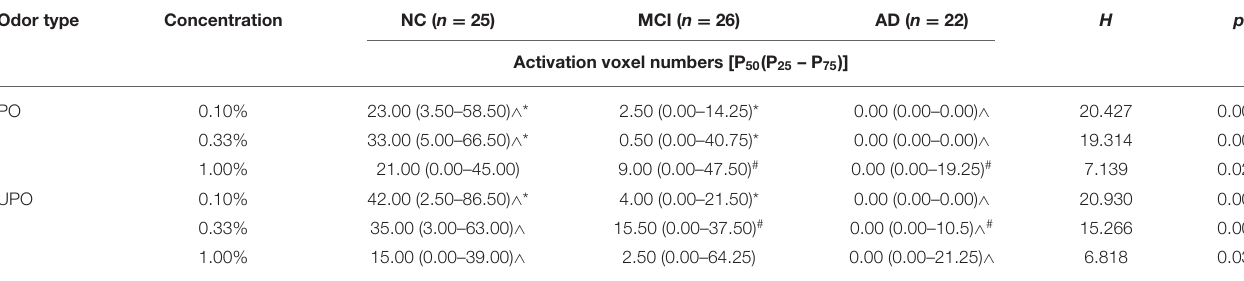
TABLE 4 | Comparison of activated voxel of primary olfactory cortex (POC) in three groups under two